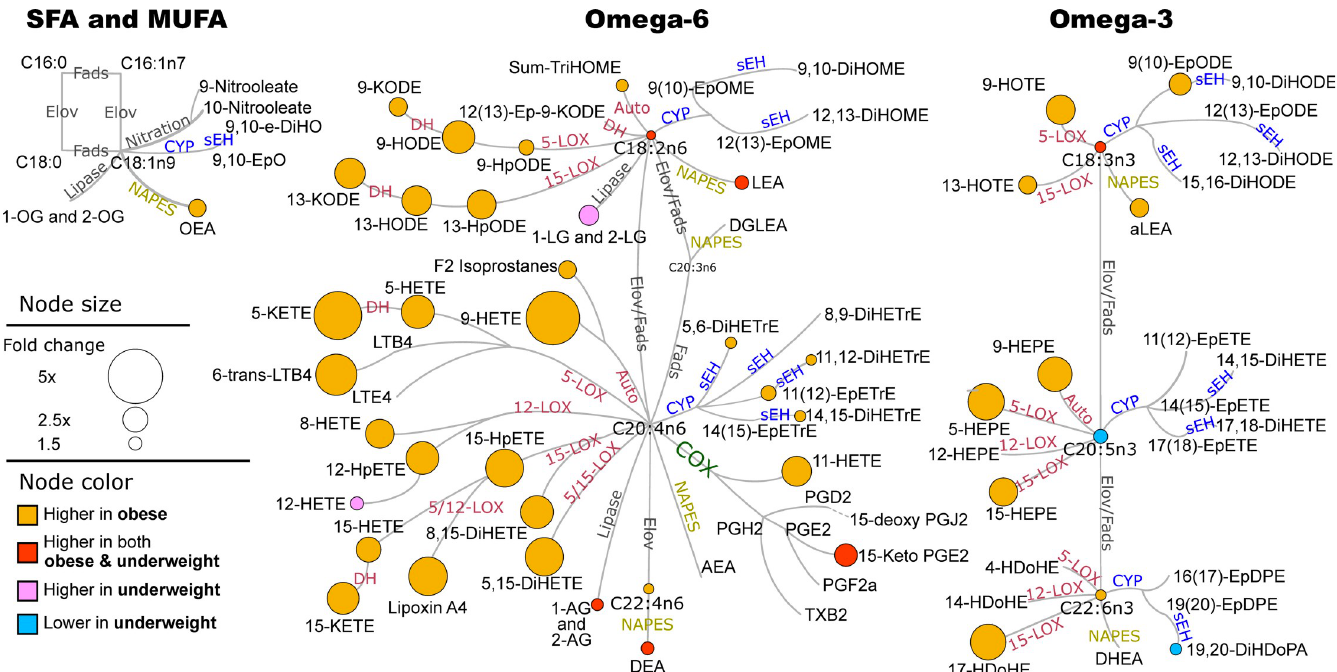
Fig 1. Differences in lipid mediators between sPTB and FTB in obese and underweight groups. Only differences with the t-test p < 0.05 are shown. Network presents fatty acids metabolic pathway, including saturates and monounsaturates (SFA and MUFA) and omega 3 and omega 6 fatty acids with oxylipins and endocannabinoids synthesis pathway. Oxylipin metabolizing enzymes are colored by their class: red–lipoxygenase (LOX) and autoxidation pathway; blue–cytochrome p450 (CYP) epoxygenase; green–cyclooxygenase (COX); yellow–N-acylphosphatidylethanolamide-phospholipase D. Node size represents the fold change (sPTB/FTB) and the color represents the BMI group where the change was observed: orange–increased only in obese; red–increased in obese and underweight; pink–increased only in underweight; blue–decreased in underweight. Fads–fatty acid desaturase; Elov–fatty acids elongase; sEH–soluble epoxide hydrolase; DH–dehydrogenase. Saturated and monounsaturated fatty acids were not measured in this assay and are indicated only to visualize parent fatty acids for measured oxylipins and endocannabinoids. Means of individual metabolites and corresponding p-values are provided in S2 Table.